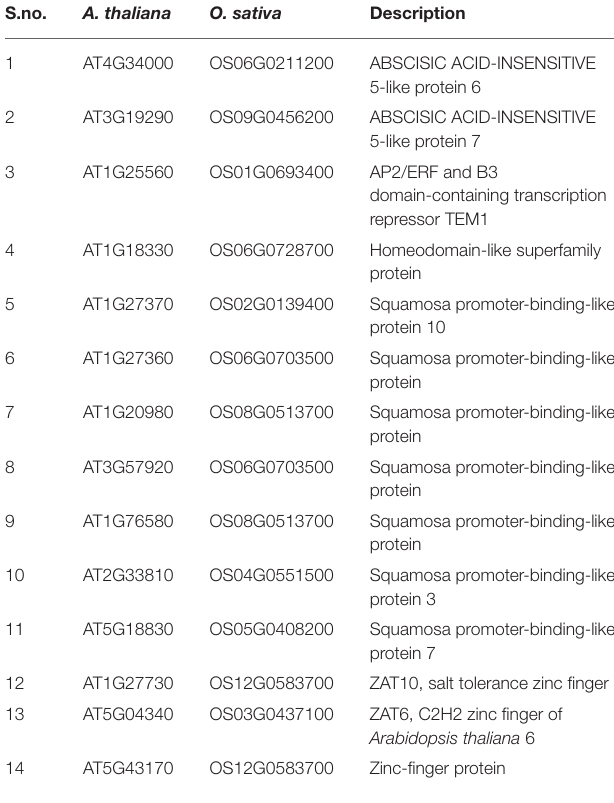
TABLE 7 | Names of the conserved TFs to the promoters of HMR genes between A. thaliana and O. sativa associated.